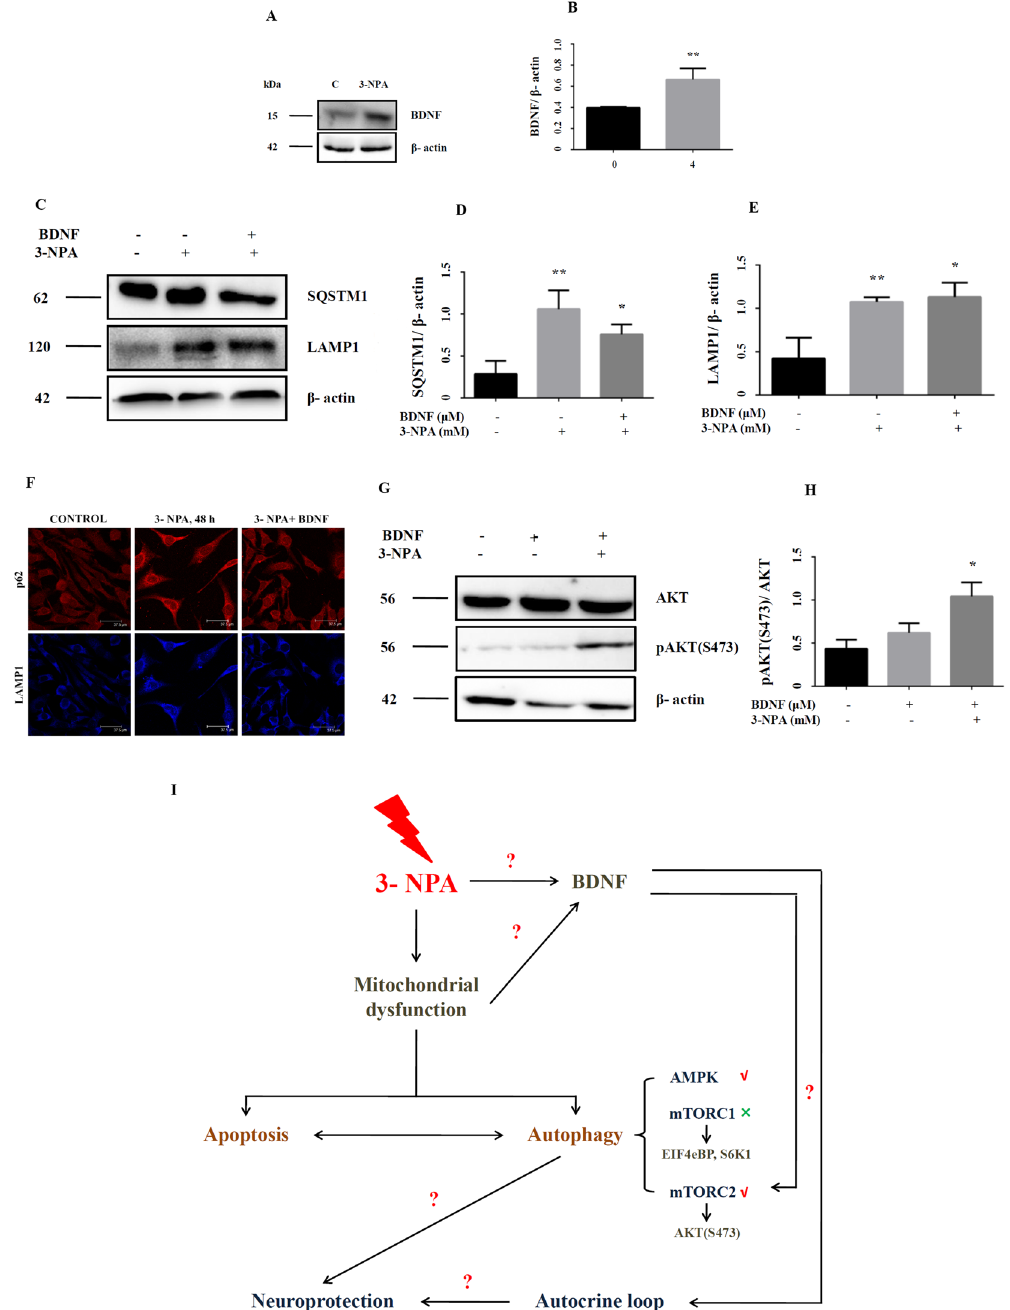
Figure 7. Growth factor mediated neuroprotection in 3-NPA treated N27 cells. Consistent with the microarray data, BDNF showed increased expression at the protein level ( A , B , corresponding complete blot in supplementary Figure 18i). Co-treatment of 3-NPA treated N27 cells with BDNF could activate mTORC2 pathway as indicated by levels of pAKT (S473) ( G , H , corresponding complete blot in supplementary Figure 18v). Autophagy was tending towards completion as indicated p62/SQSTM1 ( C , D , corresponding complete blot in supplementary Figure 18ii) and LAMP1 ( C , E , corresponding complete blot in supplementary Figure 18iii) in BDNF + 3-NPA co-treatment (n = 3 trials per experiment; *p < 0.05, **p < 0.01). This was validated further by immunocytochemistry ( F ) (n = 3 coverslips per group). ( I ) Depicts the schematic diagram summarizing the key findings of the study. 3-NPA mediated mitochondrial dysfunction alters the interaction and the ensuing balance between autophagy and apoptosis in neuronal cells with autophagy potentially conferring neuroprotection [Schematic was generated using Microsoft Powerpoint (2004)]. Autophagy pathway in the 3-NPA model entails mTORC2 (and not mTORC1) pathway and AMPK. 3-NPA mediated up-regulation of BDNF could positively influence neuroprotection either directly via autocrine loop or indirectly via upregulating the autophagy mechanism. The western data for all the proteins in this figure are from independent blots. All blots were cut to retain only the region depicting the protein of